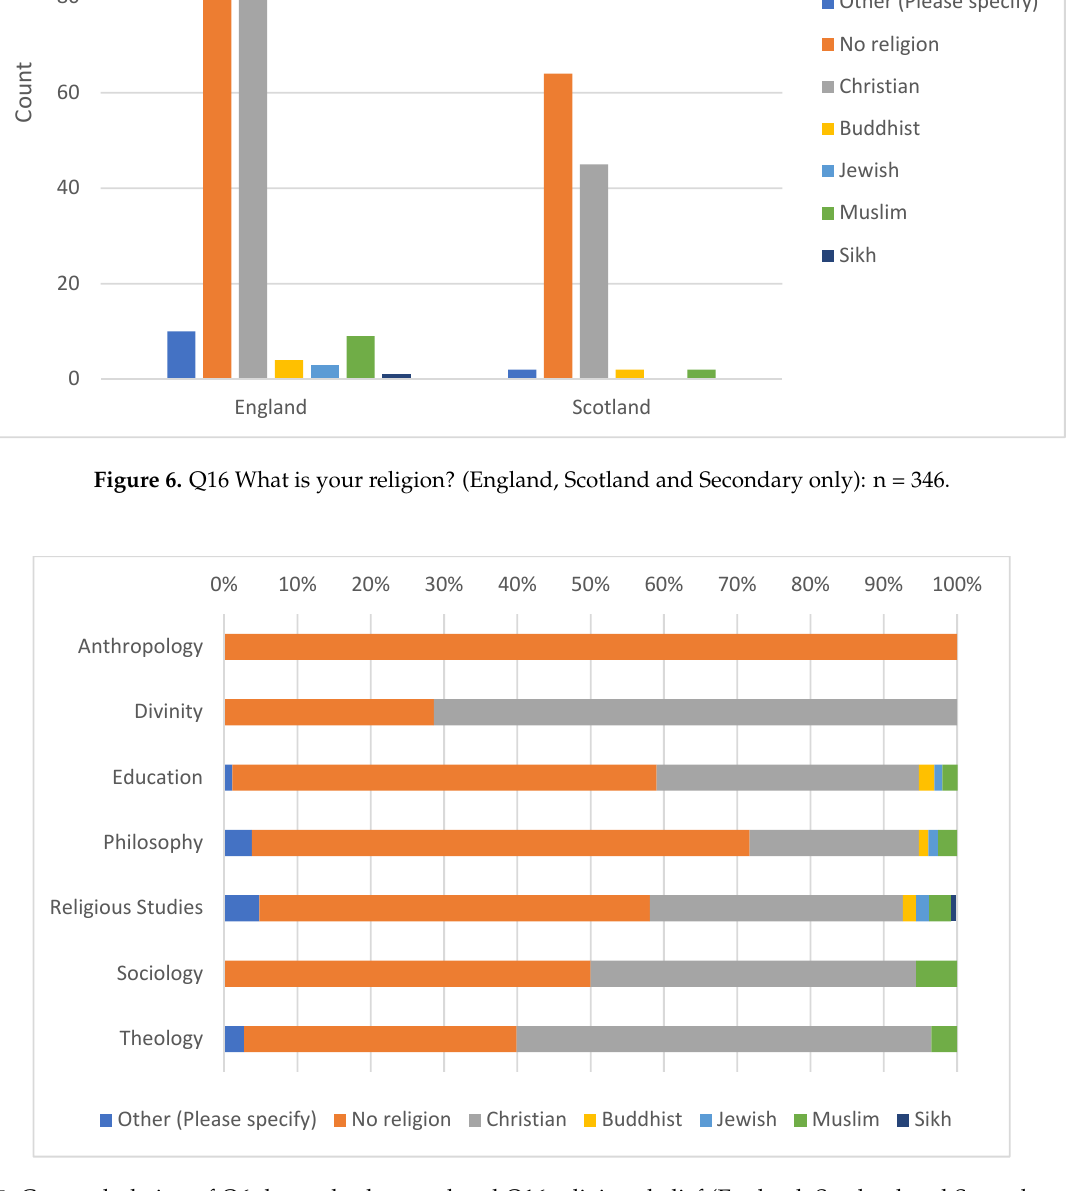
Figure 7. Cross-tabulation of Q6 degree background and Q16 religious belief (England, Scotland and Secondary only): n = 307.